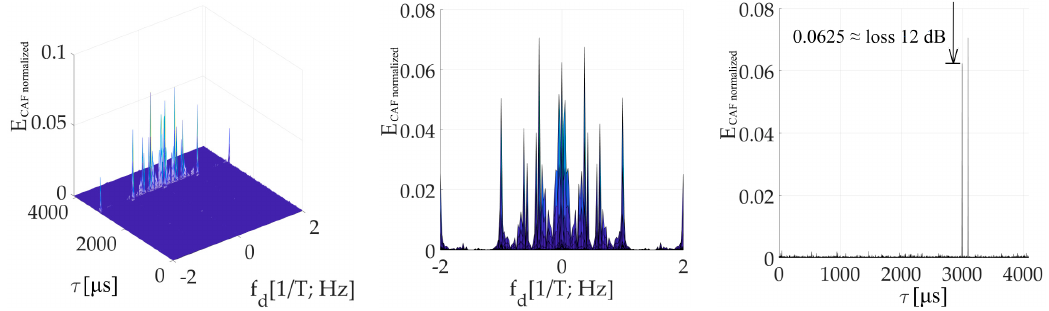
Figure 15. Resulting CAF of the mPCA pre-correlation processing of SC using the SBZP, for τ = (3/4) T . CAF ( left ), Dopler shift domain ( middle ), Code phase domain ( right ).